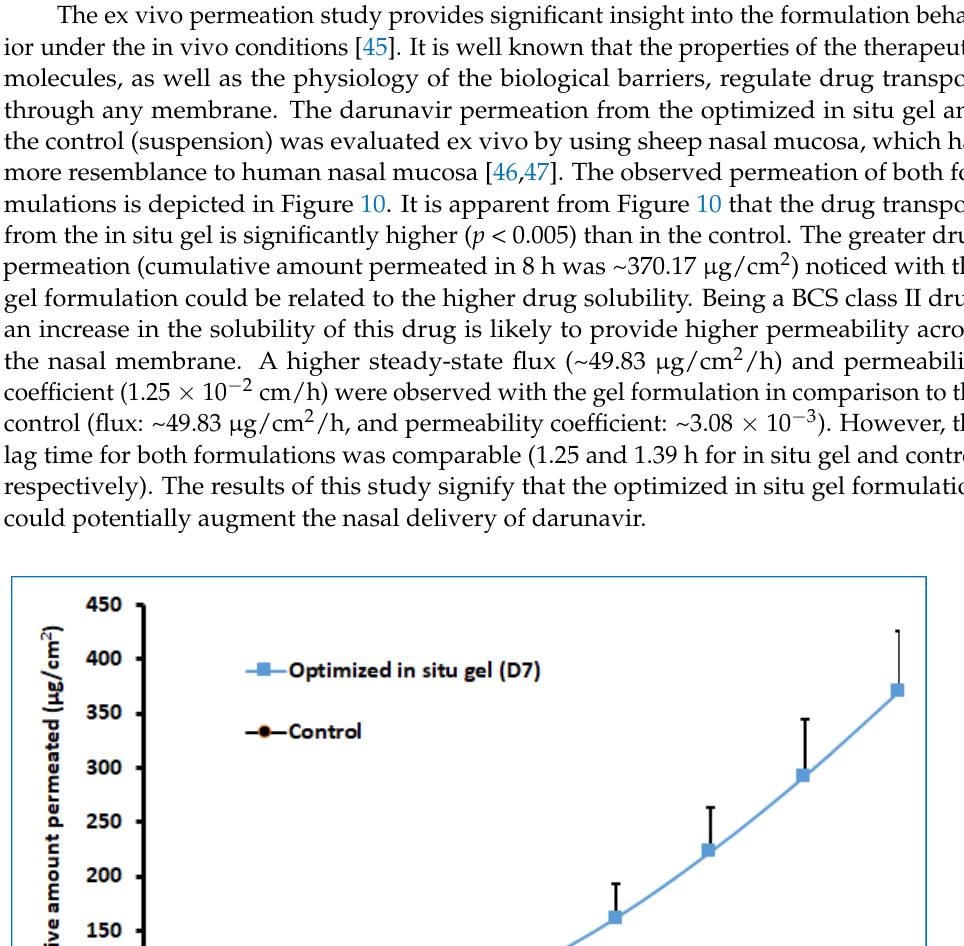
Figure 11. Histopathological examination of sections of sheep nasal mucosal membrane. ( A ) Nega- tive control: hematoxylin and eosin staining of nasal mucosa membrane applied with phosphate buffer reveal unaffected nasal cells with intact basement membranes (red arrows), as well as un- damaged glandular cells with clear nuclei (yellow arrow). ( B ) Positive control: nasal mucosa treated with isopropyl alcohol suffered severe cellular and histological damage. The treatment with isopro- pyl alcohol disrupted basement membrane (yellow arrow) and loss of nucleus of glandular cells to form a multinucleated cells. ( C ) Test: nasal in situ gel of darunavir when exposed to nasal tissues of the sheep showed intact basement membrane (red arrow) and normal arrangement of the glandular cells with well-defined nuclei (yellow arrow), indicating no signs of toxicity of the formulation.